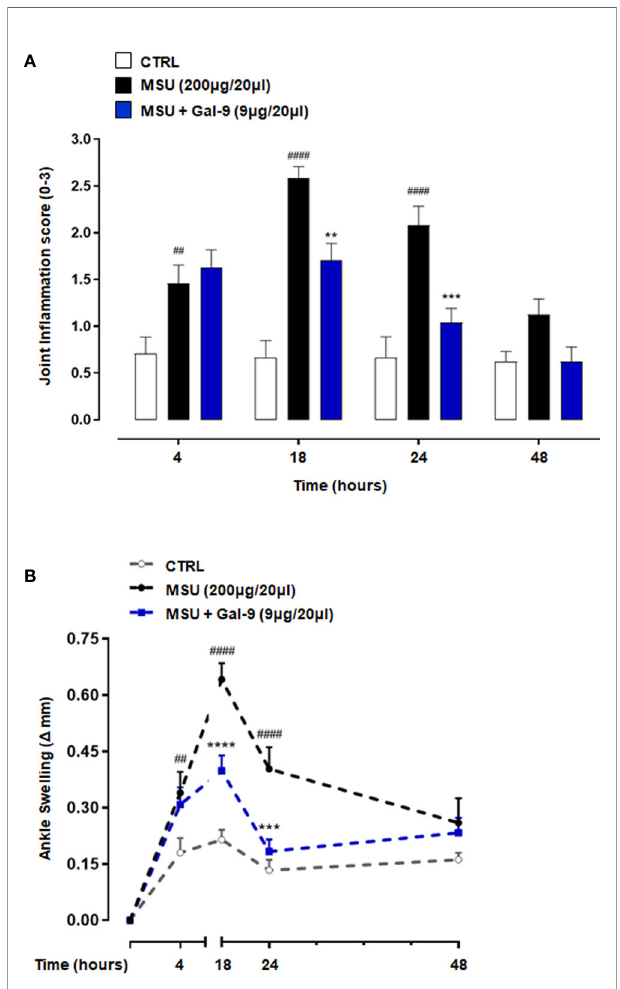
FIGURE 1 | Gal-9 attenuates MSU crystals-induced gouty in fl ammation in mouse knee joints. Mice were treated with intra-articular (i.a.) dose of Gal-9 (9 m g/20 m l) or vehicle (PBS, 20 m l) 30 mins after i.a. stimulation with MSU crystals (200 m g/20 m l) in the right knee joints. (A) Joint in fl ammation score (0-3 in increments of 0.25) and (B) joint in fl ammation oedema was evaluated at 4, 18, 24 and 48h after the stimulus with MSU. Data (expressed as joint in fl ammation score and D increase of knee joints mm respectively) are presented as means ± SEM of n = 6 mice per group. Statistical analysis was conducted by one- or two-way ANOVA followed by Bonferroni ’ s for multiple comparisons. ## P ≤ 0.01, #### P ≤ 0.0001 vs Ctrl group; **P ≤ 0.01, ***P ≤ 0.001, ****P ≤ 0.0001 vs MSU